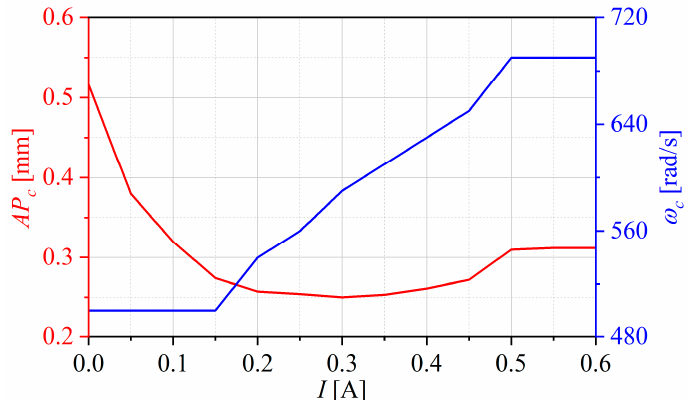
ω and AP varied with the current. Figure 12. Figure 12. ω c and AP c varied with the c c